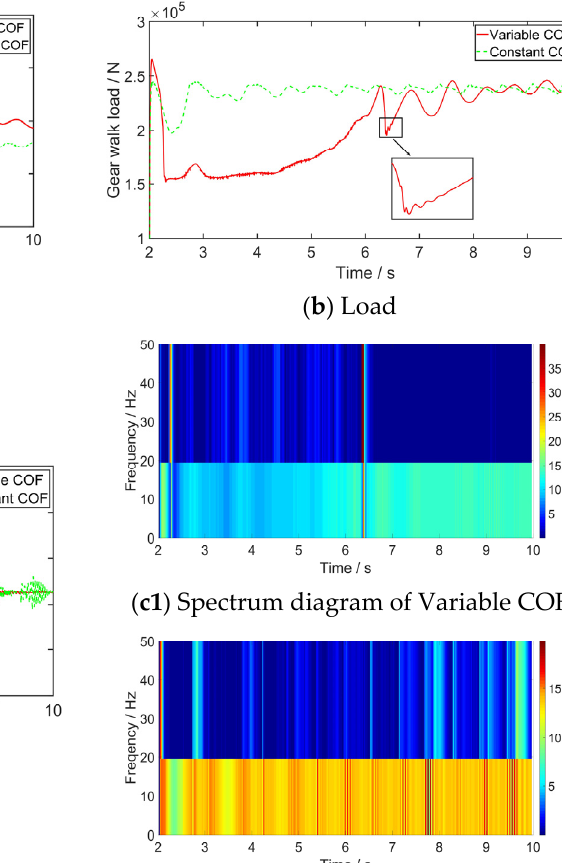
Figure 10. Relationship between the wheel speed and the friction coefficient of a C/SiC brake disc. In the process of aircraft braking, the wheel speed decreases and the brake disc tem- perature rises. With the increase of temperature, the friction coefficient decreases rapidly to below 0.28 and maintains a stable change. When the temperature reaches 400 °C , the friction coefficient rises rapidly to above 0.52. This causes the brake torque to be affected with the same trend of change, and the brake torque causes changes to the wheel slip rate. The adhesion coefficient between the tire and the ground and the ground adhesion mo- ment decreased first and then increased. The load of the gear walk also decreased at first and then increased due to the influence of the ground adhesion moment. The “negative slope” phenomenon of the C/SiC brake disc will affect the braking stability of the landing gear and exacerbate the gear walk.